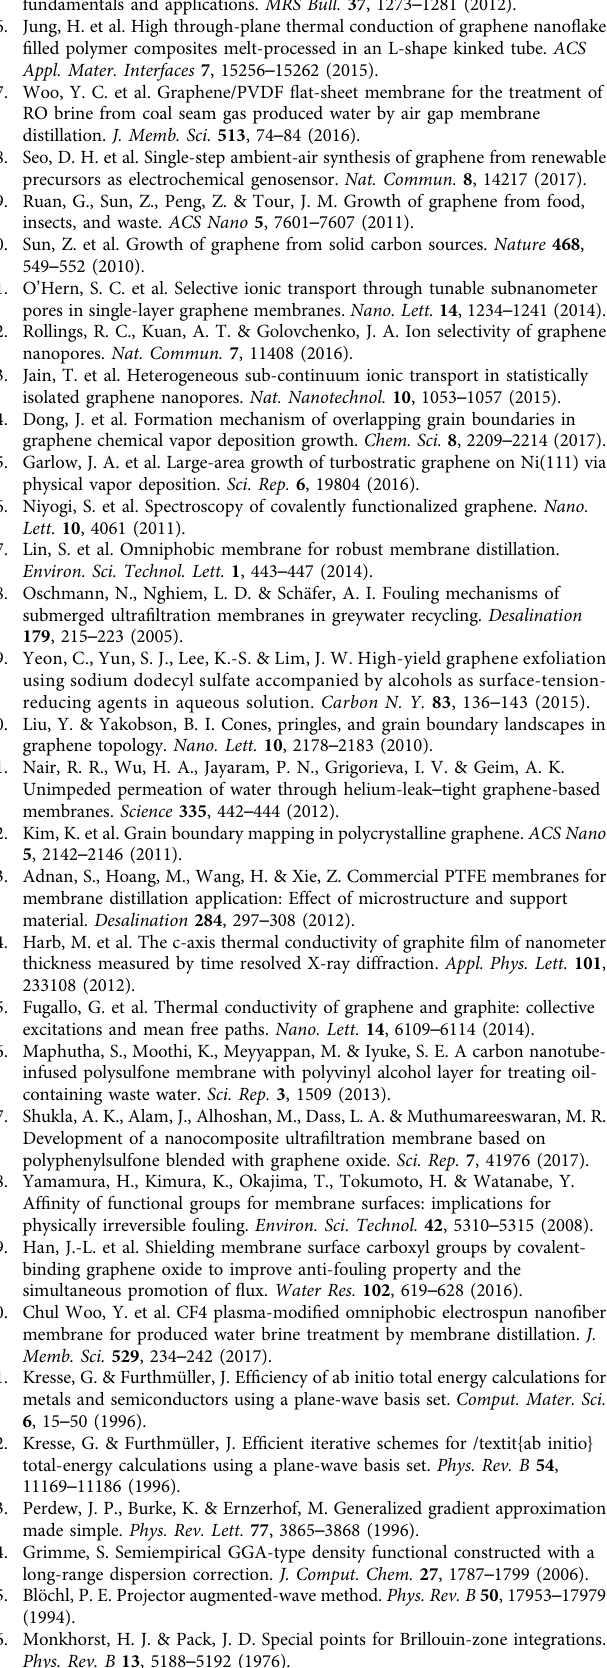
fi rst Brillouin zone. The energy barrier for H 2 O migration through the graphene sheets was obtained by using the climbing image-nudged elastic band (CI-NEB) method 47 . For the graphene grain boundaries, the adsorption energy E ad of the SDS and H 2 O molecule is obtained according to E ad ¼ E comb (cid:2) E bound (cid:2) E mo where E comb , E bound and E mo represent the total energy of the SDS molecule/H 2 O- adsorbed graphene boundary, pure graphene boundary and the SDS or